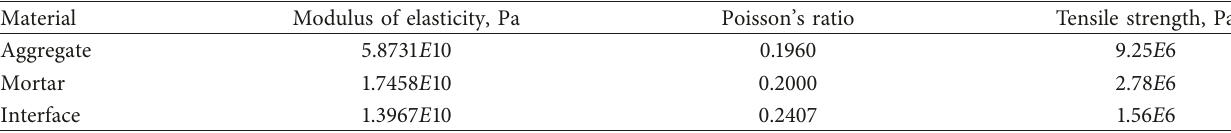
Table 1: The proportion of concrete mixture in Dagang Mountain.